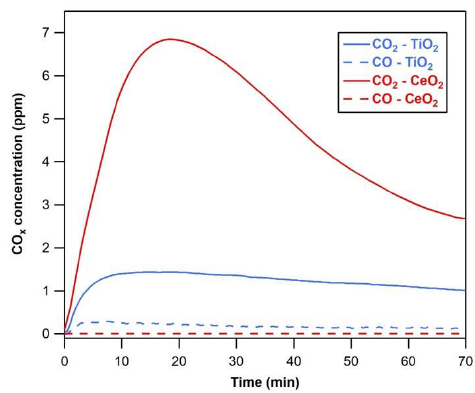
Figure 8. Temporal evolutions of the mineralization percentages of organics adsorbed on TiO 2 and CeO 2 along the individual exposure to ozone of the metal oxides preliminarily exposed to acetone; reported data are derived from Figure 7 (flow rate = 750 mL/min, [O 3 ] 0 = 22 ppm for CeO 2 experi- ments, [O 3 ] 0 = 24 ppm for TiO 2 ; 100 mg CeO 2 , 200 mg TiO 2 ). The contrasted CO 2 dynamics may sound unexpected since: (i) the absolute amounts of acetone taken up on TiO 2 (23 µmol) exceeded the one taken up on CeO 2 (16 µmol); while (ii) the amounts of O 3 consumed were equivalent between both systems. One hypothesis to explain these contrasted behaviors relies on the fact that the oxidation pathway differs between TiO 2 and CeO 2 , not directly because of their different chemical natures, but be- cause they induce differences in the chemical nature of the adsorbed organics. More pre- cisely, the high and transient formation of CO 2 using CeO 2 (Figure 7) suggests that, as the ozonation is initiated, a significant fraction of the organic phase adsorbed on CeO 2 is more compliant with the ozone reaction than organics adsorbed on TiO 2 . In spite of the fact that TiO 2 and CeO 2 have preliminarily adsorbed the same initial VOC, namely acetone, they induce a significant conversion of acetone on their surface into surface intermediates. This reactive adsorption is effective on both oxides, with similar pathways, but with contrasted kinetics, leading to the presence of similar (mesithyl oxide) and different (DAA and for- mate) oxidation intermediates. Consequently, the higher mineralization percentage observed in Figure 8 for CeO 2 was not due to a higher consumption of ozone or a higher amount of organics present on its surface, but rather to a difference in the nature of organic adsorbates compared to TiO 2 . From that point of view, the mineralization ability of a metal oxide under post-plasma